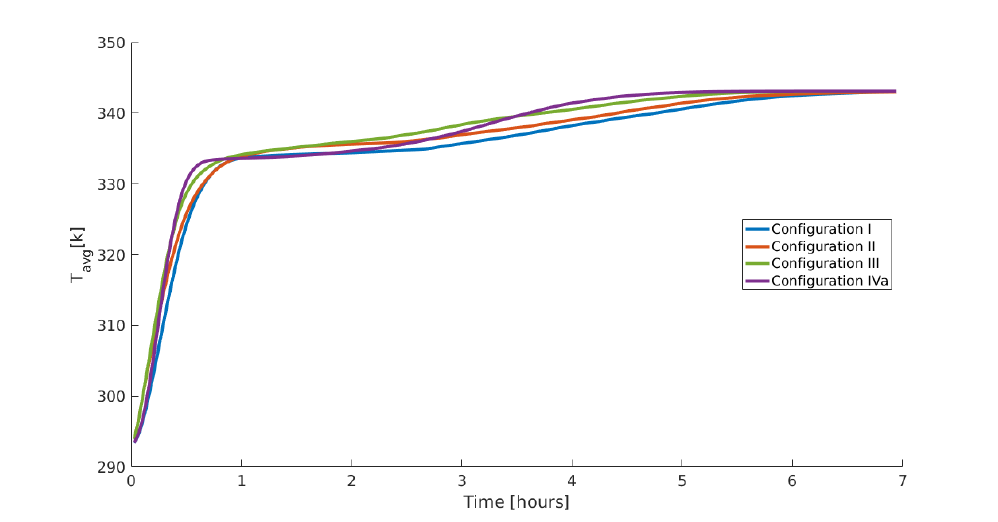
Figure 6. Average particle temperature for different configurations during the heating process.